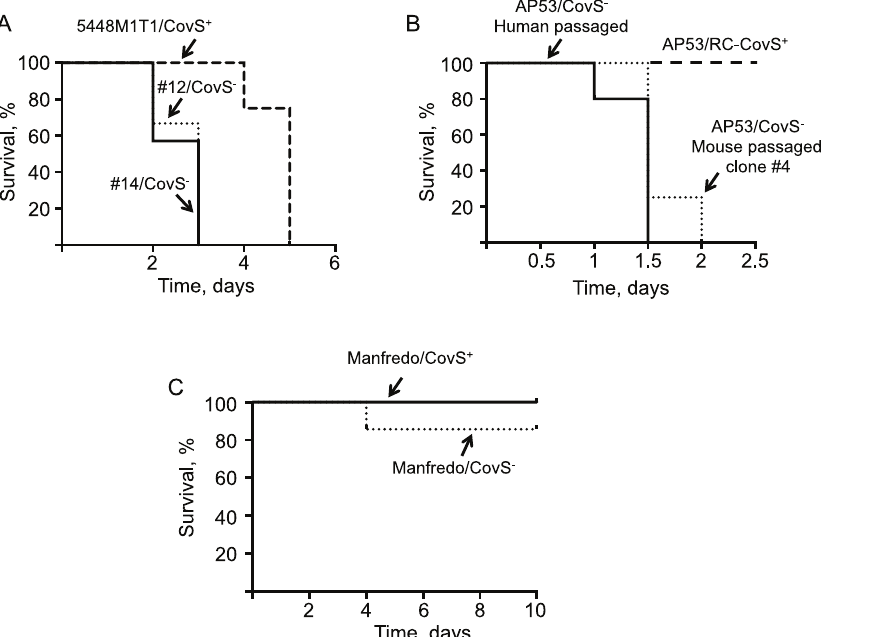
Figure 4. Survival of hPg-transgenic mice after infection with mouse-passaged GAS strains. C57Bl/6[hPg(Tg)] male mice (6–10 weeks of age) containing the hPg transgene were injected subcutaneously with GAS cells and the mice were monitored for death as an end-point. (A) 5448/ CovR + S + /M1 + , and mouse-passaged 5448/CovR + S 2 /M1 + strains # 12 (skin) and # 14 (skin). A total of 1.2 6 10 7 cells were injected. P , 0.05 when comparing the wild-type strain to the two MP strains. (B) AP53/CovR + S 2 /M53 + (human passaged) and AP53/CovR + S 2 /M53 + clonal strain # 4 (Table 3) obtained after mouse passaging of AP53/CovR + S + /M53 + . A dose of 1 6 10 8 cells was injected. P , 0.05 when comparing the covS + strain to the human passaged or mouse passaged covS mutants. (C) Manfredo/CovR + S + /M5 + and Manfredo/CovR + S 2 /M5 + clonal strain # 3 (Table 4) obtained after mouse passaging of Manfredo/CovR + S + /M5 + . A total of 1.4 6 10 7 cells were injected. These two curves were not statistically different. N=4–8 mice for each tested